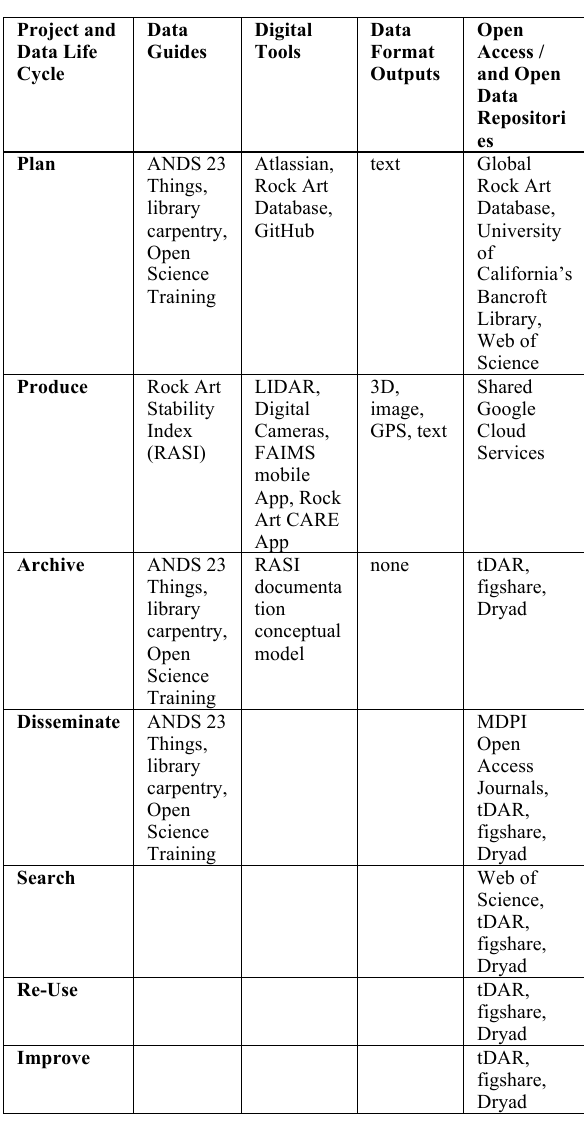
Table 1. Examples for an Integrated Research Method